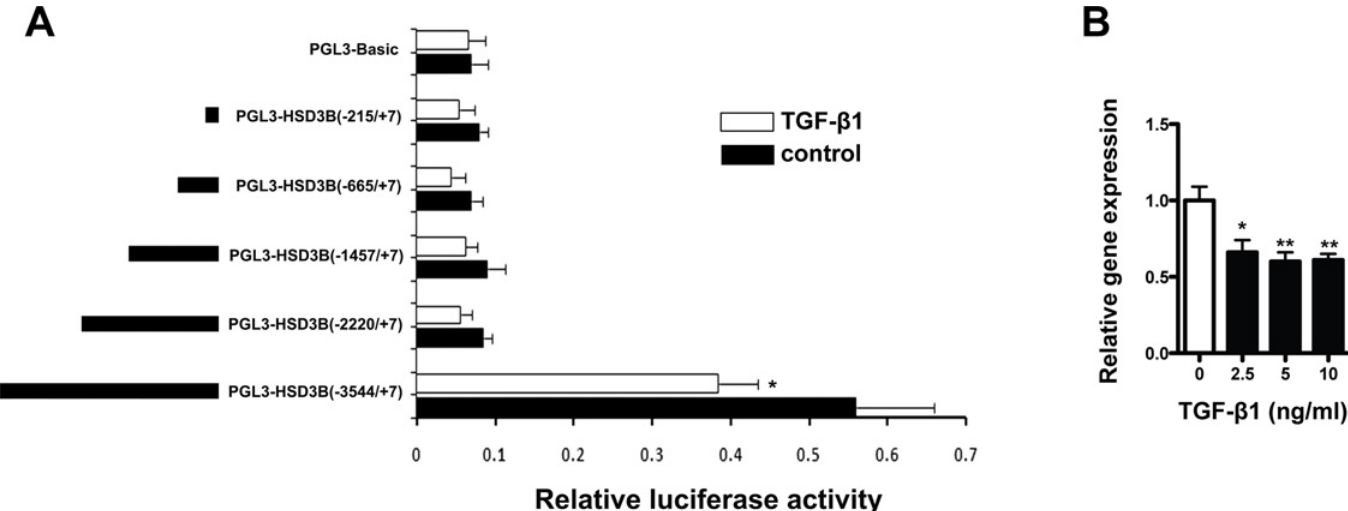
Fig 2. Effect of TGF- β 1 on the transcription of Hsd3b gene. ( A) Granulosa cells were transfected with Hsd3b promoter reporter constructs containing 5 0 serial deletions. Twenty-four hours later, cells were treated with TGF- β 1 (5 ng/ml). A renilla luciferase reporter plasmid was used as the internal control to correct for transfection efficiency. (B) qPCR shows Hsd3b gene expression was inhibited by TGF- β 1. All the data are presented as the mean ± SEM from at least four independent experiments. The housekeeping gene GAPDH was used for normalization. Student t-test was used to analyze the luciferase activity in TGF- β 1 treated cells compared to control. One-way ANOVA followed by Tukey multiple range test was used to analyze Hsd3b gene expression in granulosa cells after different TGF- β 1 treatments. * P < 0.05, ** P < 0.01.